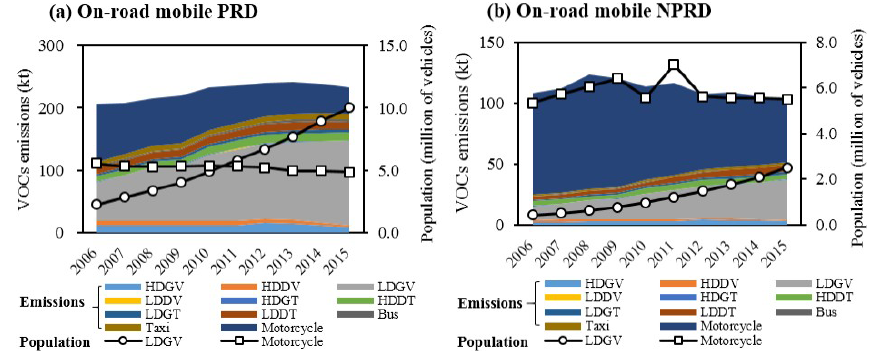
Figure 9. Trends of VOC emissions from the on-road mobile source (left axis) and its activity data (right axis) from 2006 to 2015 in (a) PRD and (b) NPRD. Emissions are presented by sub-category in the on-road mobile